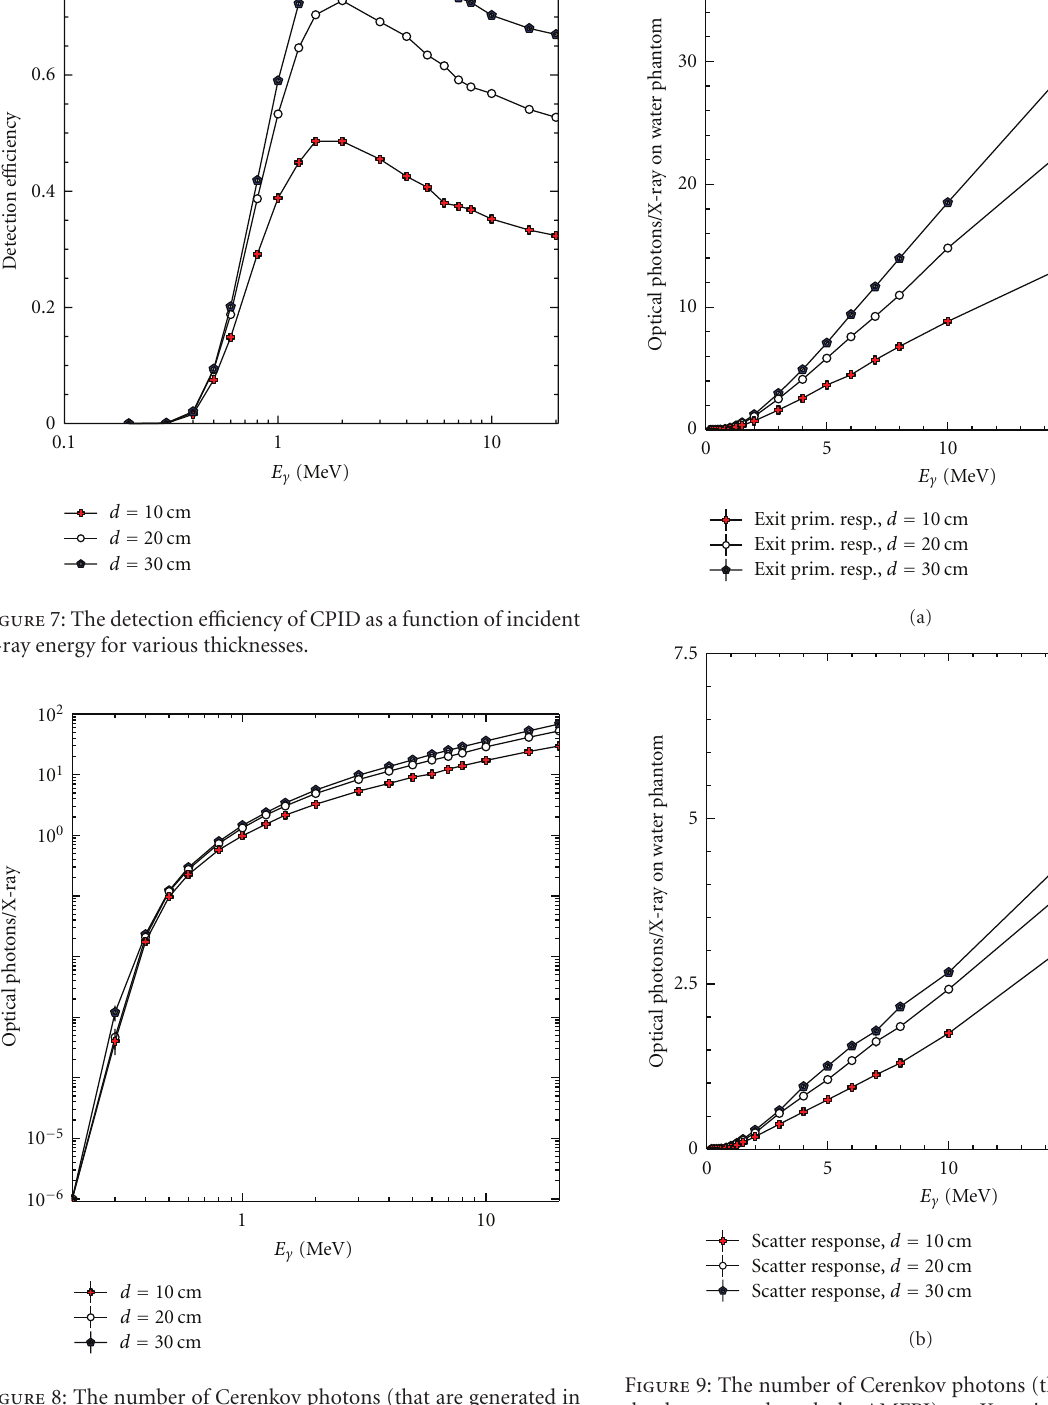
Figure 8: The number of Cerenkov photons (that are generated in the detector and reach the AMFPI) per incident X-ray as a function of incident X ray energy.